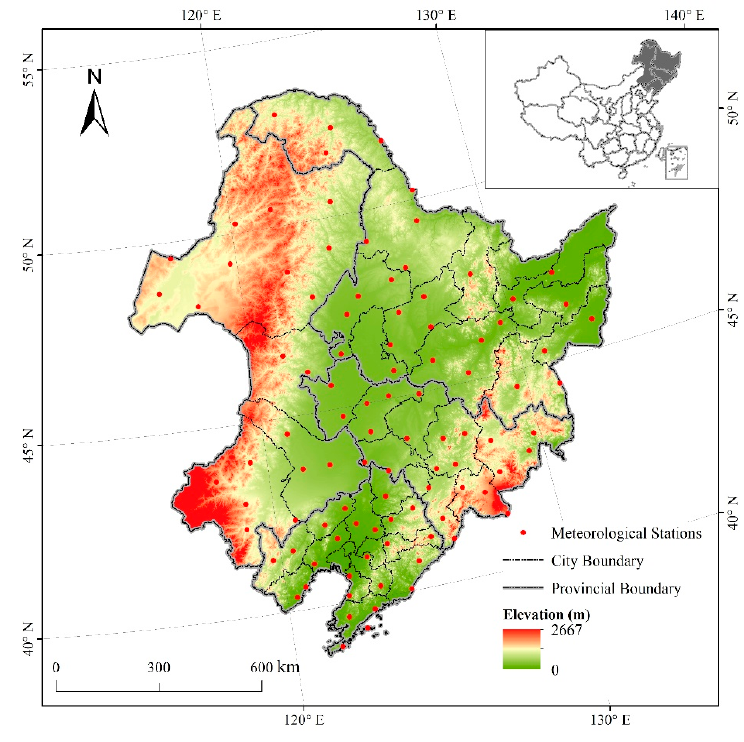
Figure 1. Location of the study area in China. Table 1. Actual maize production and total grain production in Northeast China in 2015.